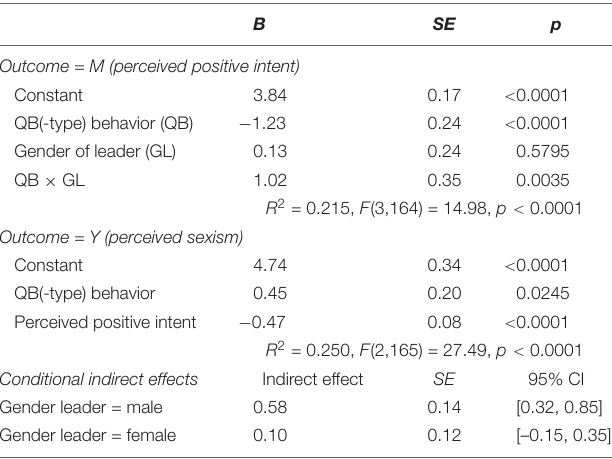
TABLE 3 | Conditional indirect effects of QB(-type) behavior on perceived sexism through perceived positive intent. B SE